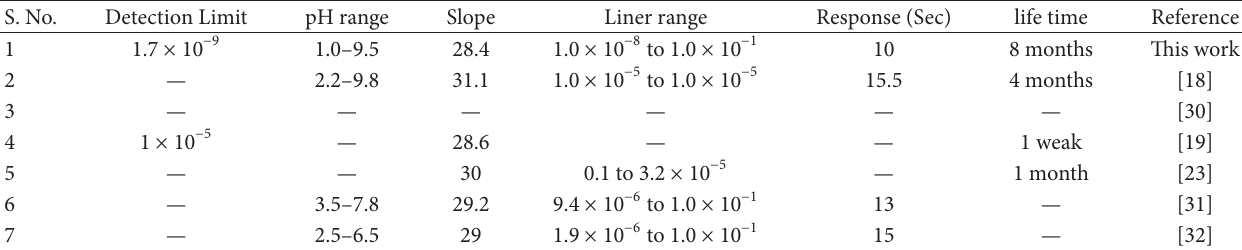
T 4: Comparison with other reported